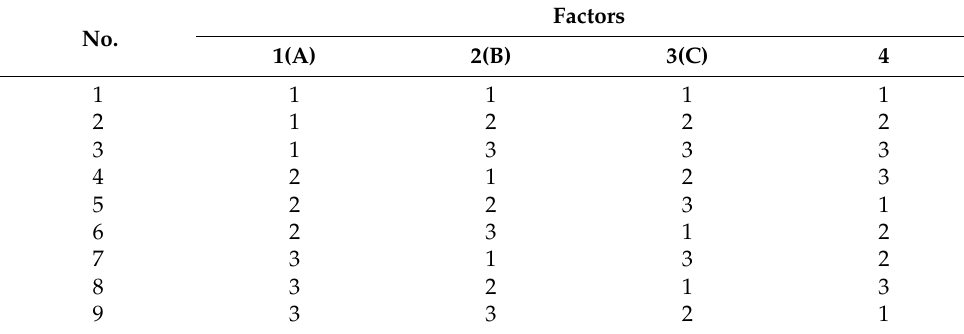
Table 3. Part of orthogonal regression experimental design